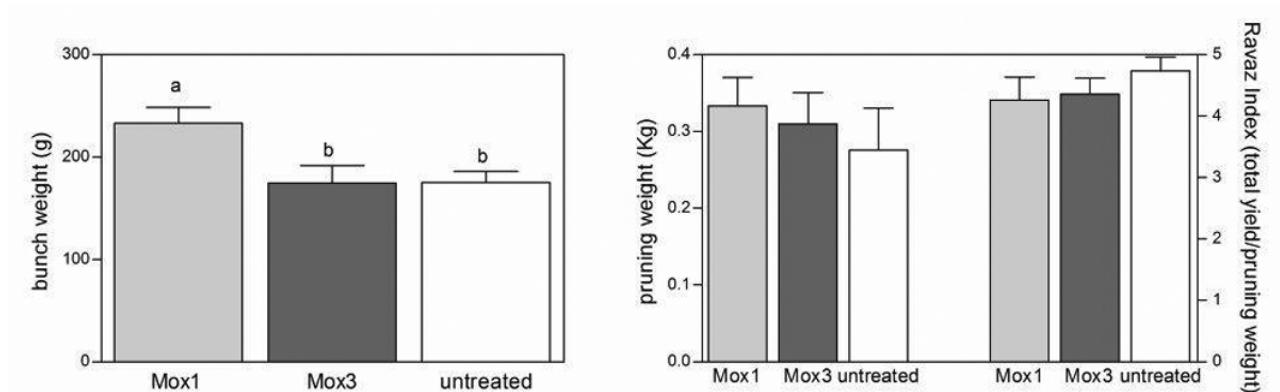
Fig. 4 - Bunch weight (left), total pruning weight and Ravaz index (right) measured in Mo-treated and untreated grapevine plants. Right: Error bars reflect the LSD at p ≤ 0.05. Different letters correspond to significant differences (p ≤ 0.05). Non-significant results are marked NS